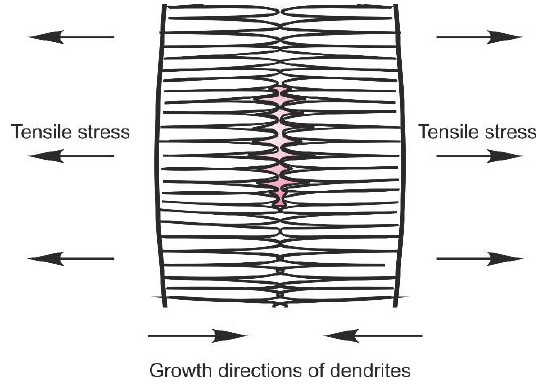
Figure 18. Schematic representation of solidification cracking in the bulging region.